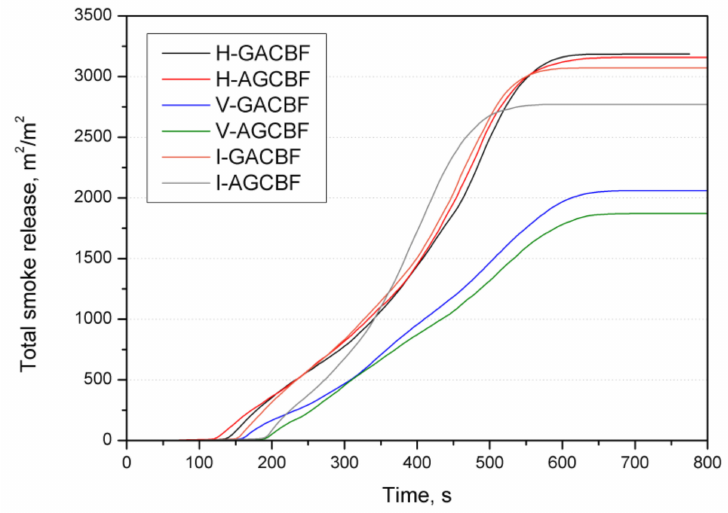
Figure 9. Representative curves of the total smoke release of the EP-based